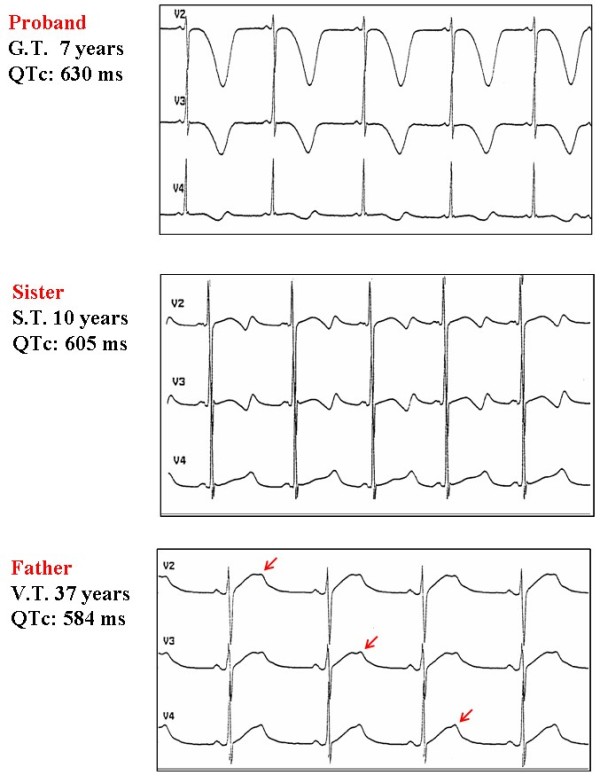
Different T wave morphologies in affected members of the same family. The proband had a documented cardiac arrest as first manifestation of LQTS. The basal ECG shows deep negative T waves in the precordial leads and a very prolonged QTc. His sister is still asymptomatic with typical bi-phasic T waves. His father, with notched T waves and a QTc 584 ms, has had 2 syncopal episodes. The arrows point to examples of notched T wave. [Reprinted from: Schwartz PJ, Priori SG, Napolitano C: The long QT syndrome. In: CARDIAC ELECTROPHYSIOLOGY. FROM CELL TO BEDSIDE. III EDITION (Zipes DP and Jalife J, Eds.) WB Saunders Co., Philadelphia, pp. 597–615, 2000 – with permission from Elsevier].